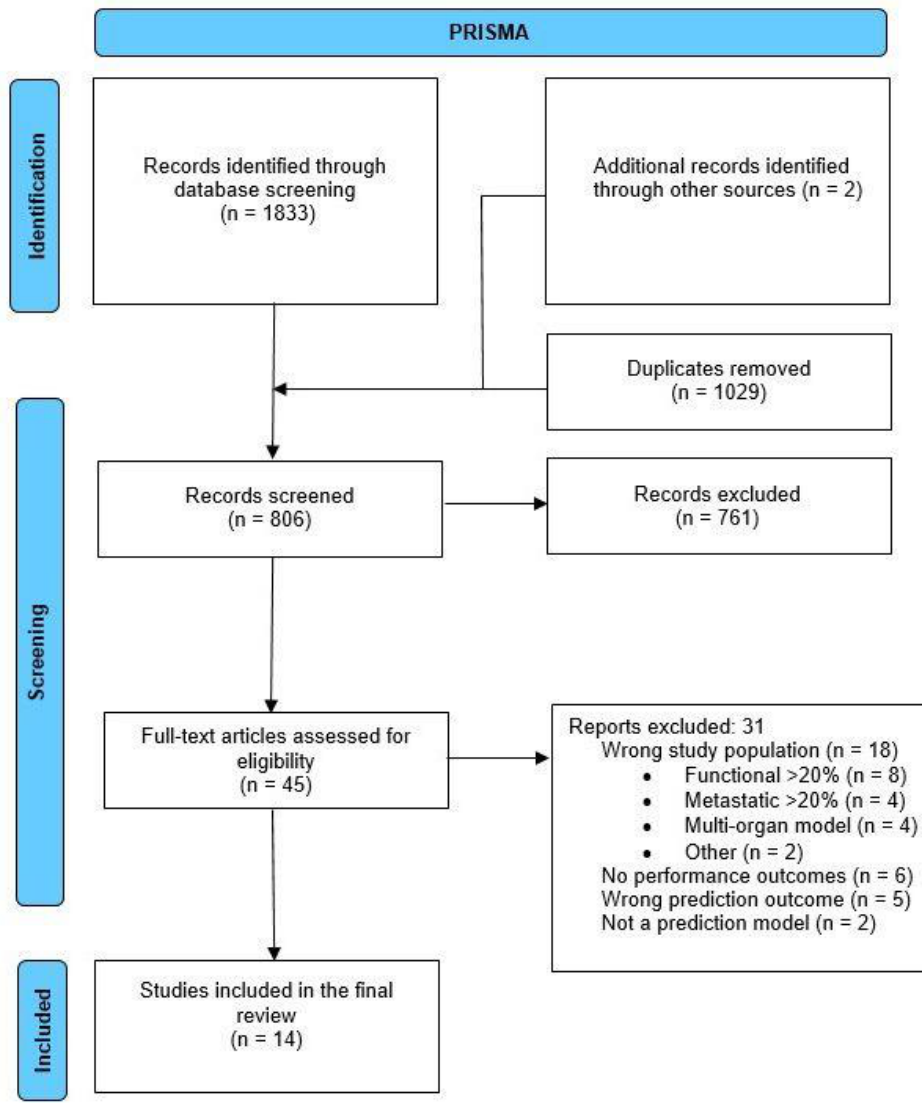
Figure 1. Preferred Reporting Items for Systematic Reviews and Meta-Analysis (PRISMA) flow diagram reporting the number of studies identified, screened, and selected for inclusion in this systematic review.